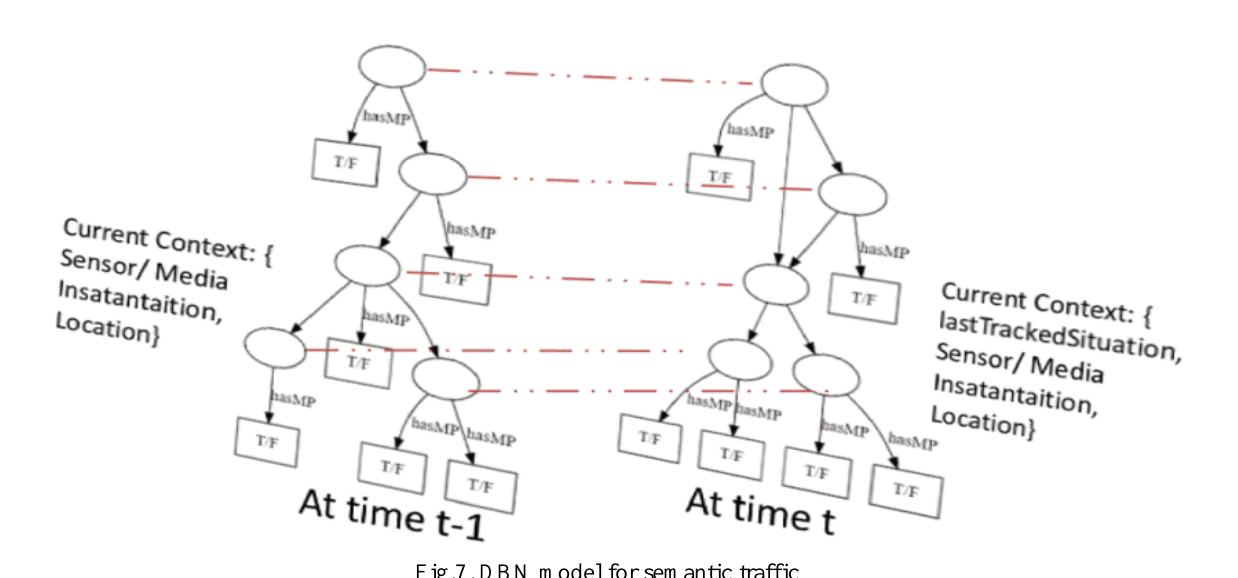
Fig.7. DBN model for semantic traffic